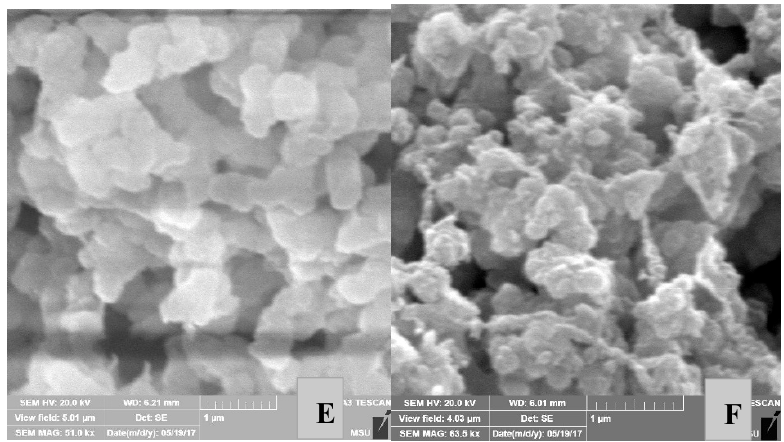
Figure 6. SEM images of the surface morphology of PE powders obtained from catalytic systems III in entries 17 ( A ), 19 ( B ), 21 ( C ), 17 ( D , increase 1 µ m), 19 ( E , increase 1 µ m), and 21 ( F , increase 1 µ m).